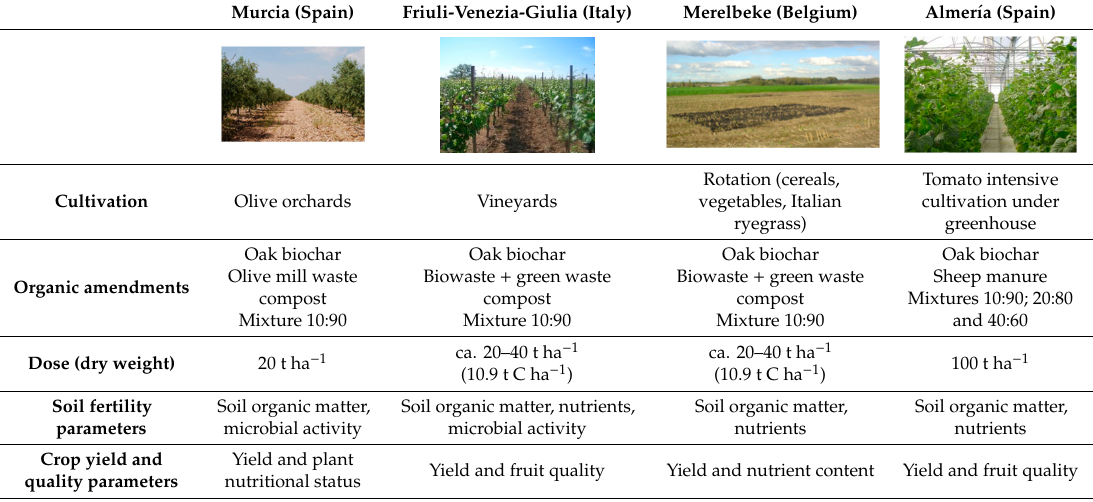
Table 1. Description of the common methodological strategy used for the agronomical evaluation of biochar and compost applications at the four experimental sites across Europe.